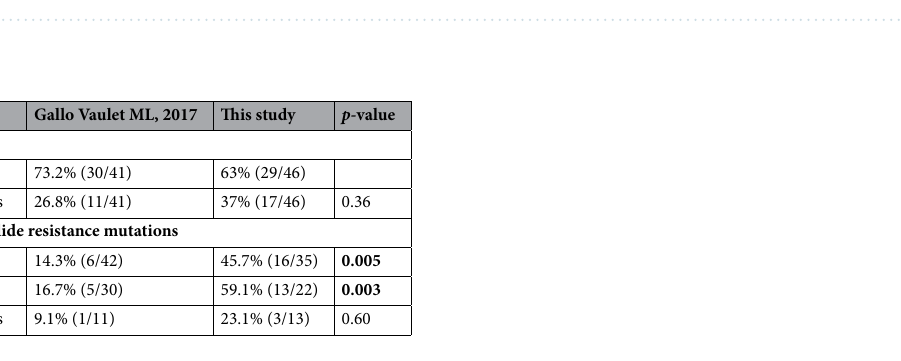
Table 4. Comparison of clade and macrolide resistance frequencies between studies. Significant values are in bold.